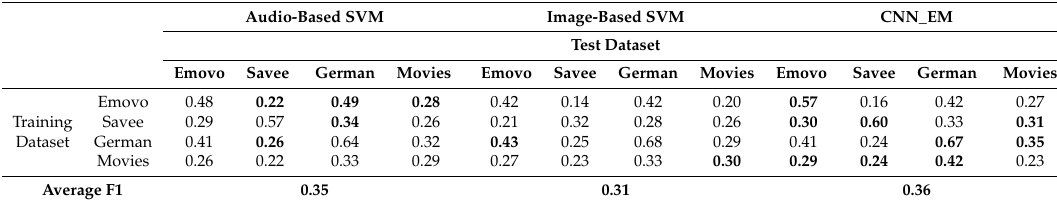
Table 3. Experimental results indicating the testing error of the proposed method and comparisons to other methodologies. Each row indicates the training and each column the testing set used. We mainly focus on the average F1 measure as the final evaluation metric, due to its ability to be robust against unbalanced datasets. Numbers in bold indicate which method achieved highest performance in each experiment.